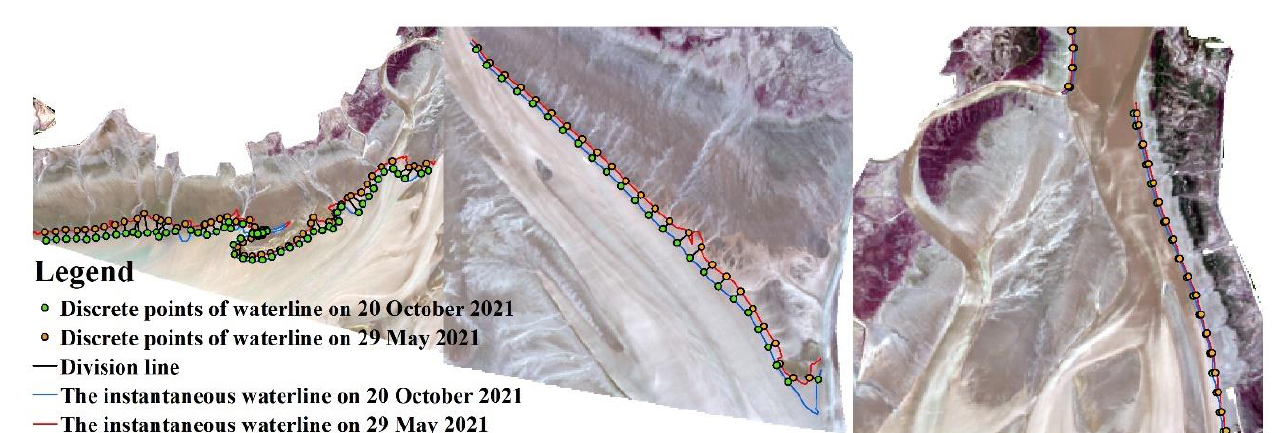
Figure 4. Tidal correction schematic diagram using instantaneous water edges. Table 1. Tidal information calculated by the remote sensing images at the scene center time.